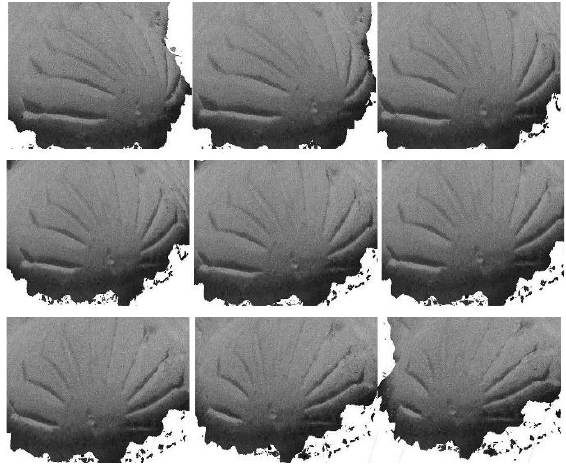
Figure 9. Images of the cut fragment from the hologram model.